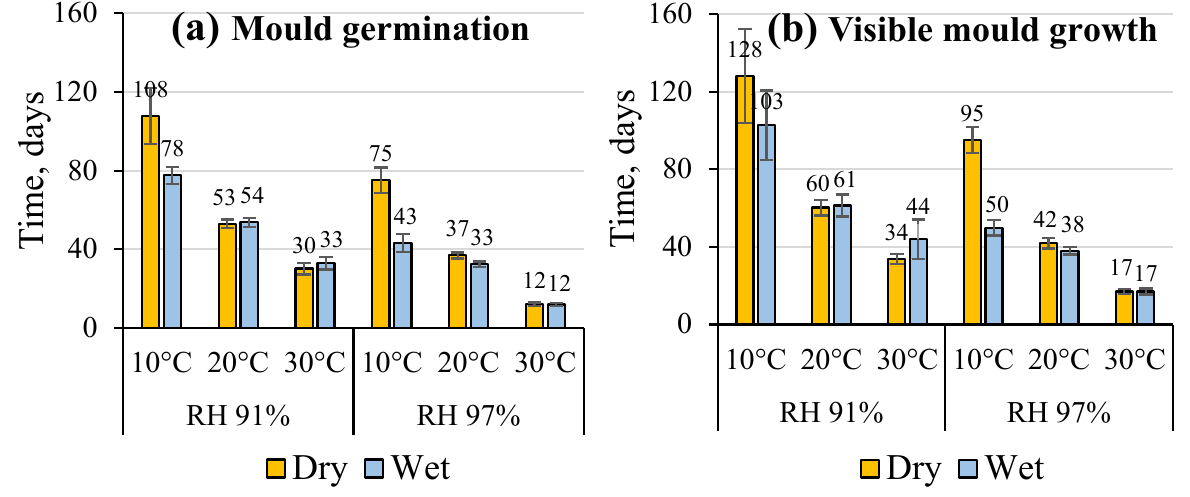
Figure 4. Time needed to reach definite mould growth stage for ‘Dry’ and ‘Wet’ specimens at different conditions: ( a ) mould germination and ( b ) visible mould growth.